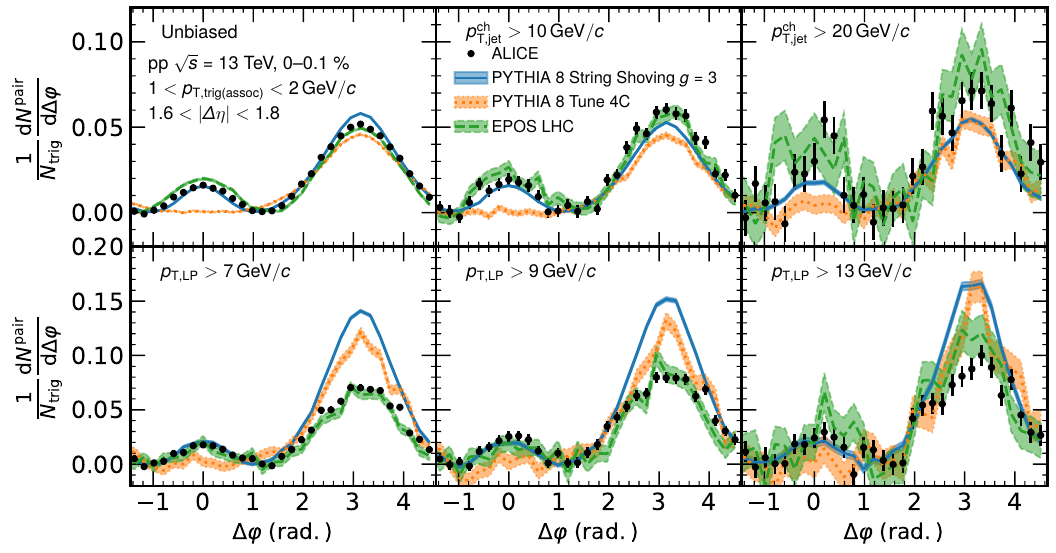
Figure 5 . One-dimensional ∆ ϕ projections of the correlation functions constrained to 1.6 < | ∆ η | < 1.8 in HM events with an additional event-scale bias. Top: with an imposed selection on the leading jet p T , bottom: with an imposed selection on the leading particle p T . ALICE data are compared with prediction of